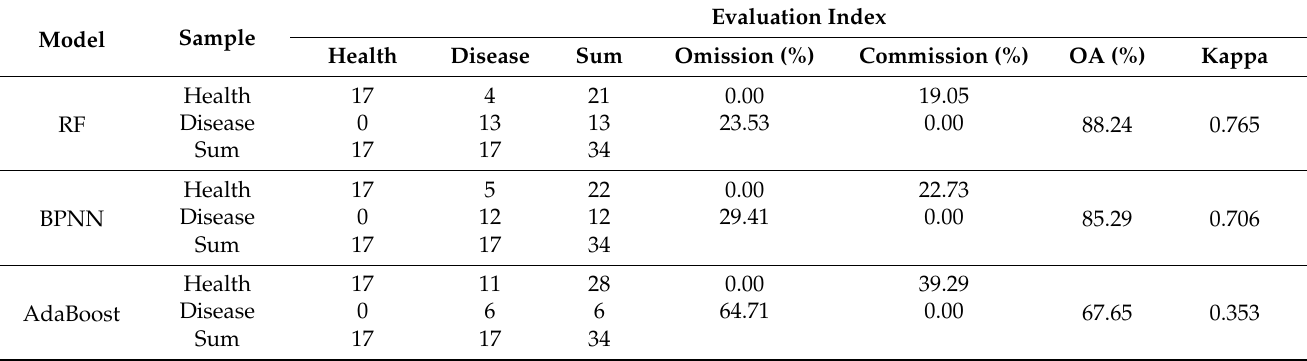
Table 4. Verification results of the three monitoring models based on feature variables